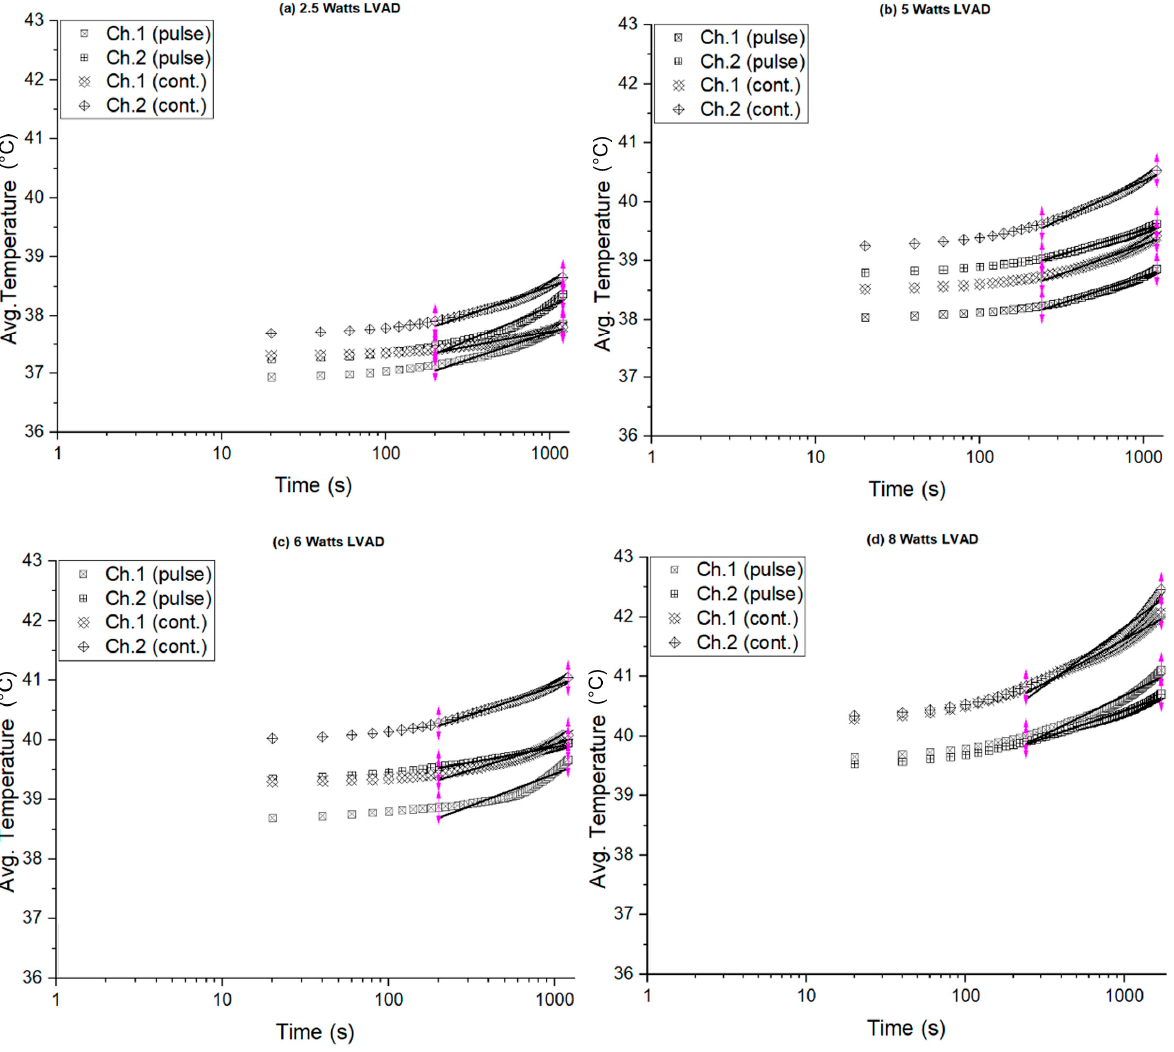
Figure 8. In vivo temperature measurements from the implanted coils: ( a ) 2.5 W, ( b ) 5 W, ( c ) 6 W, and ( d ) 8 W power rated LVAD (semi-log scale).